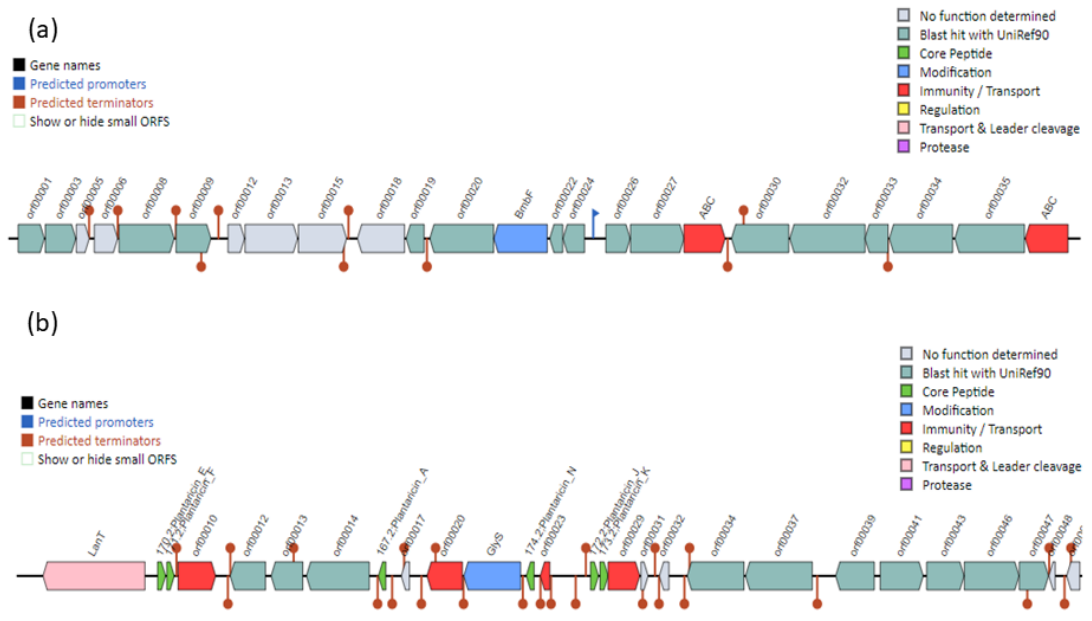
Figure 4. The organization of bacteriocin gene clusters in the Lactiplantibacillus plantarum DJF10 genome was predicted through the BAGEL4 webserver. The area of interest at contig 6 and 10 indicates sacpeptides ( a ) and plantaricin J ( b ) classes, respectively.